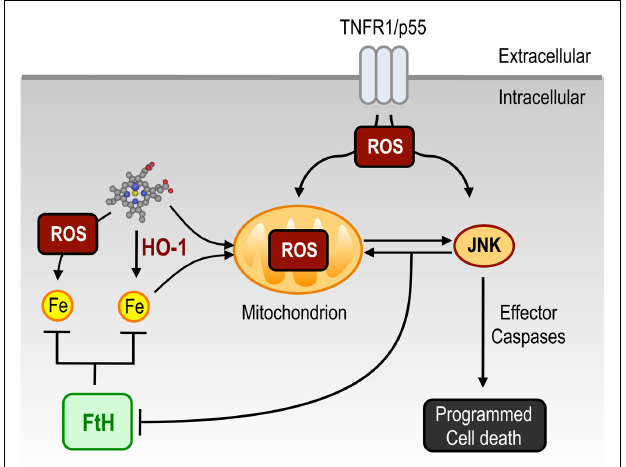
FIGURE 2 | Pathophysiological effects of heme. Free heme can sensitize parenchyma cells to undergo PCD in response to pro-inflammatory signals such asTNF. Under homeostatic conditions, cellular heme is degraded via HO-1 activity and the labile Fe released in this manner, is scavenged by FtH, thus preventing oxidative stress. Under a variety of inflammatory conditions, the concentration of intracellular free heme can exceed the rate of heme catabolism by HO-1. In addition, accumulation of cellular labile Fe can also overcome FtH scavenging capacity.When this occurs, free heme and/or labile Fe accumulate in cells, thereby boosting mitochondrion-driven ROS. Activation of theTNF receptor leads to further generation of ROS, resulting in sustained JNK activation which promotes FtH degradation (Antosiewicz et al., 2007), leading to further labile Fe overload and hence to further ROS generation via Fenton chemistry. Moreover, sustained JNK activation lead to the activation of effector caspases thereby inducing PCD. Abbreviations: FtH, ferritin; HO-1, heme oxygenase-1; JNK, c-Jun N-terminal kinase; ROS, reactive oxygen species;TNF, tumor